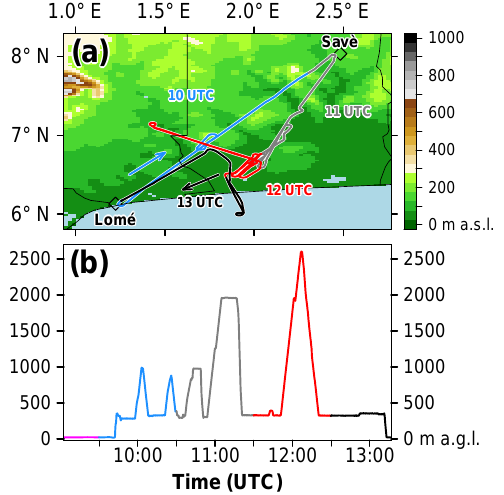
Figure 5. Flight track of the ATR42 SAFIRE on 3 July 2016 between 08:32 and 13:13UTC in the (a) horizontal and (b) vertical dimension (ma.g.l.). In (a) the topography (ma.s.l.) is added. The flight track in (a) and (b) is separated into hourly time steps for subsequent collocation with hourly model data from COSMO-ART, highlighted in pink (08:32–09:30UTC), blue (09:30–10:30UTC), gray (10:30–11:30UTC), red (11:30– 12:30UTC) and black (12:30–13:13UTC). Furthermore, the arrows in (a) indicate the flight direction with the takeoff at Lomé, the flight to Savè and the return to Lomé airport. Note the meridional com- pression of the map in (a) .